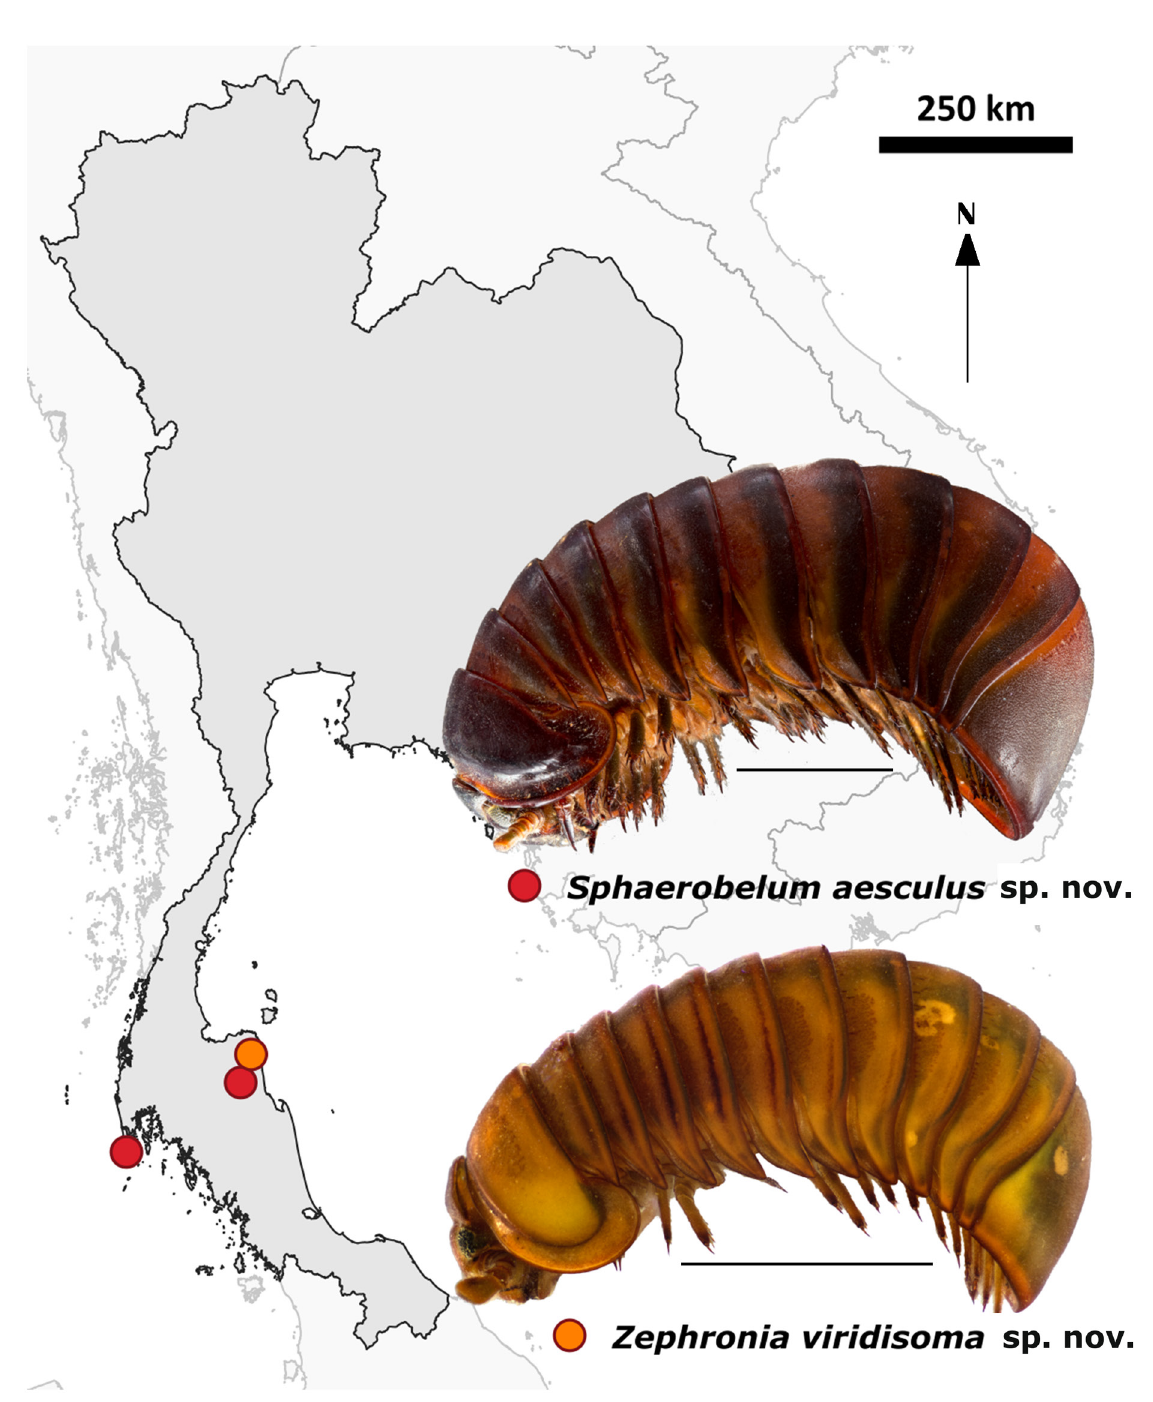
Fig. 2. Map of Thailand, collection localities of Sphaerobelum aesculus Rosenmejer & Wesener sp. nov. and Zephronia viridisoma Rosenmejer & Wesener sp. nov., and habitus photographs: S. aesculus Rosenmejer & Wesener sp. nov., ♀ (NHMD 621694); Z. viridisoma Rosenmejer & Wesener sp. nov., paratype, ♀ (ZFMK MYR8787). Scale bars = 1